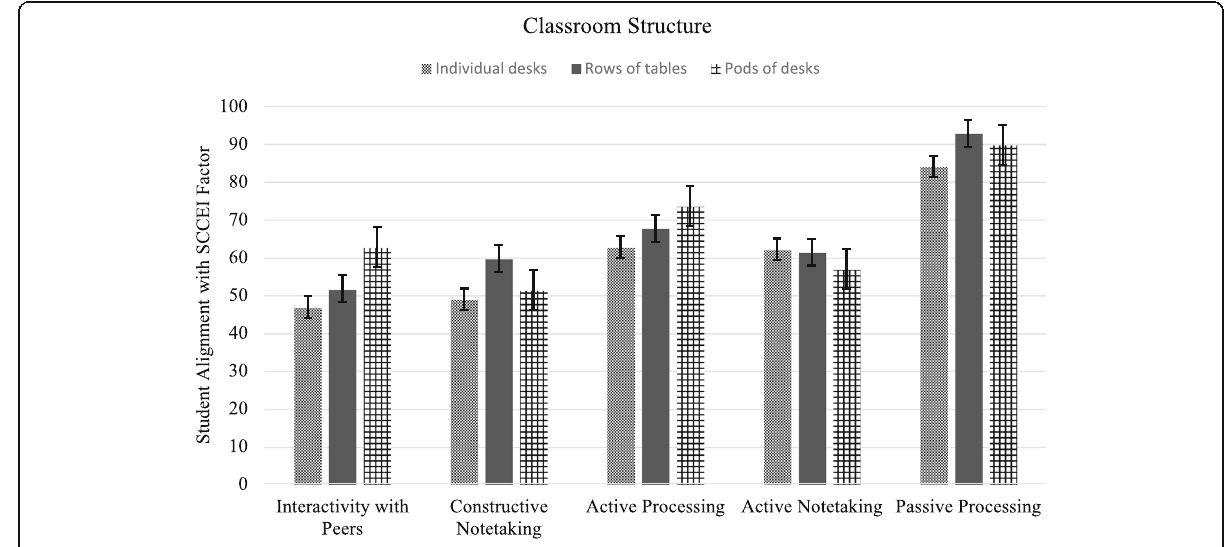
Fig. 1 Variance in SCCEI factor means based on classroom